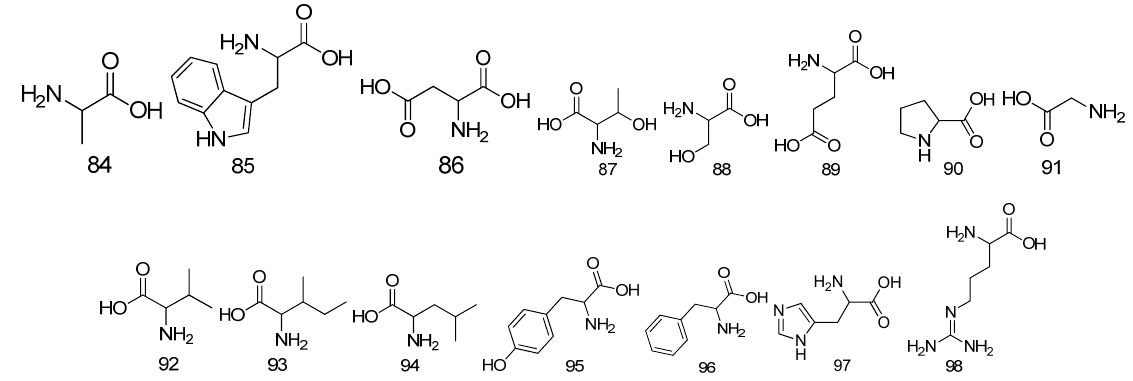
Figure 8. The chemical structures of amino acids identified from Fructus Malvae .